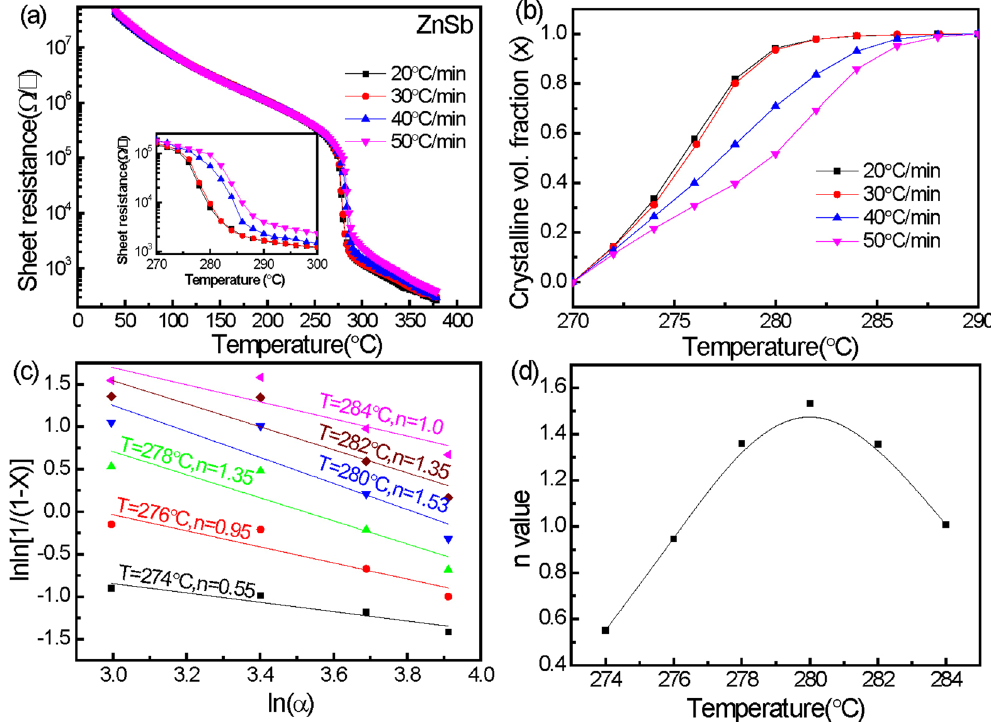
Figure 7. Results taken from ZnSb film using the of ( a ) R–T curves at different heating rates, ( b ) curves showing fraction of crystallization at different heating rates, ( c ) Ozawa’s plot, and ( d ) temperature-dependent kinetic